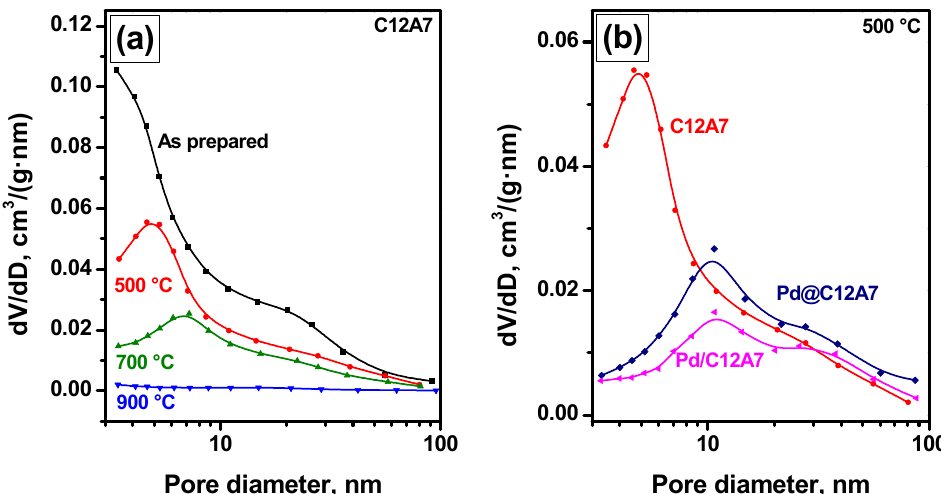
Figure 1. Pore size distributions for pure C12A7 calcined at different temperatures ( a ) and its comparison with Pd-containing C12A7 samples calcined at 500 °C ( b ). Table 1. Textural characteristics of pure and Pd-containing C12A7 samples.